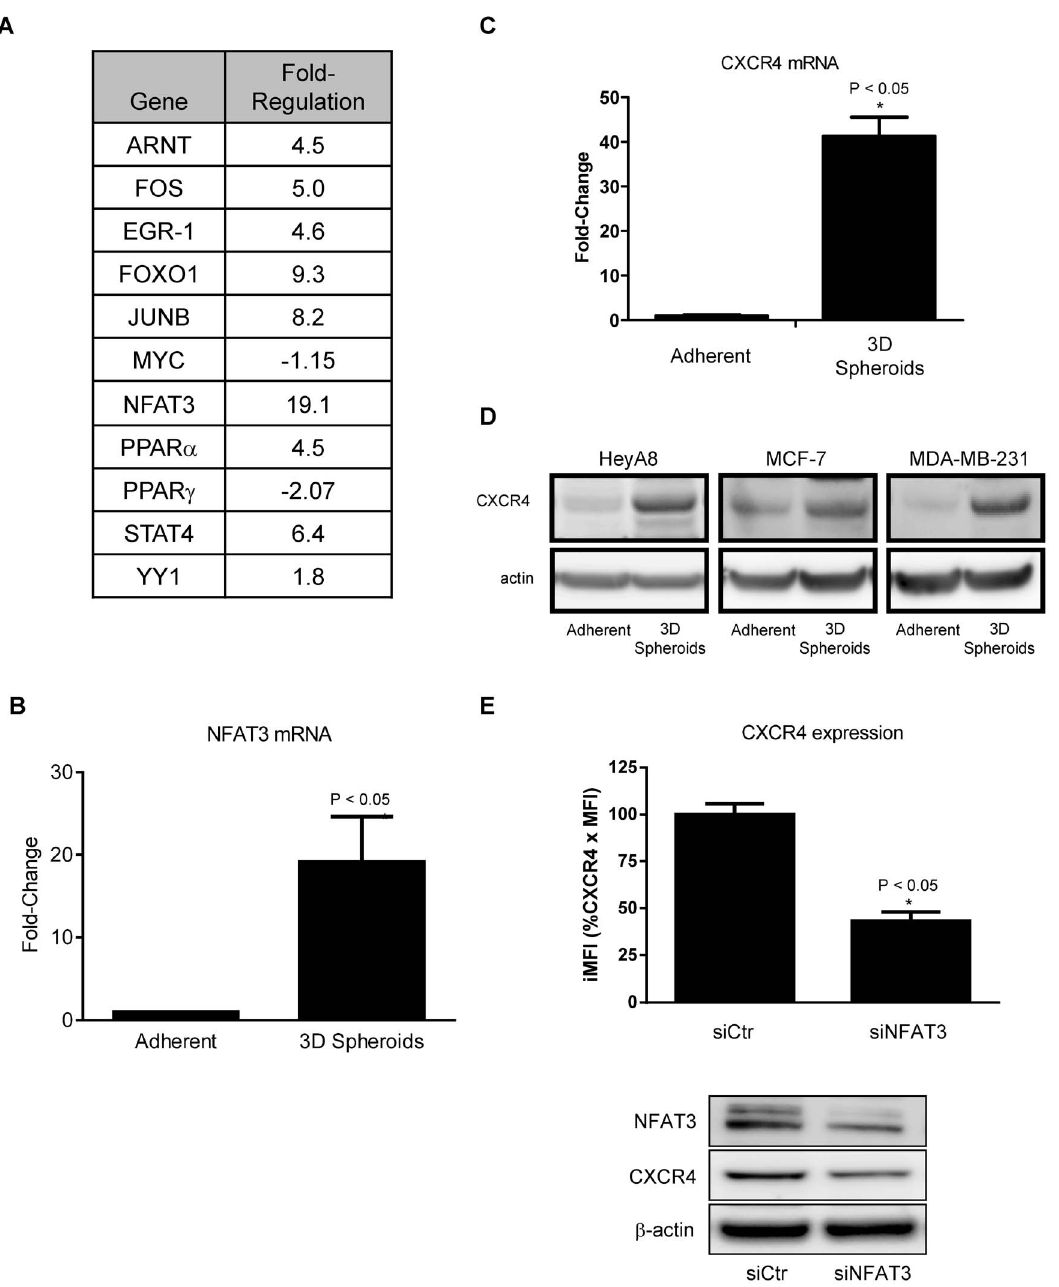
Fig. 5. 3D spheroids enhance NFAT3 and CXCR4 expression. PCR array of transcription factors was performed according to manufacturer’s protocol. The 3D spheroids have 100,000 cells per spheroid. ( A ) A list of transcriptional factors with the corresponding fold change in mRNA expression in cultured